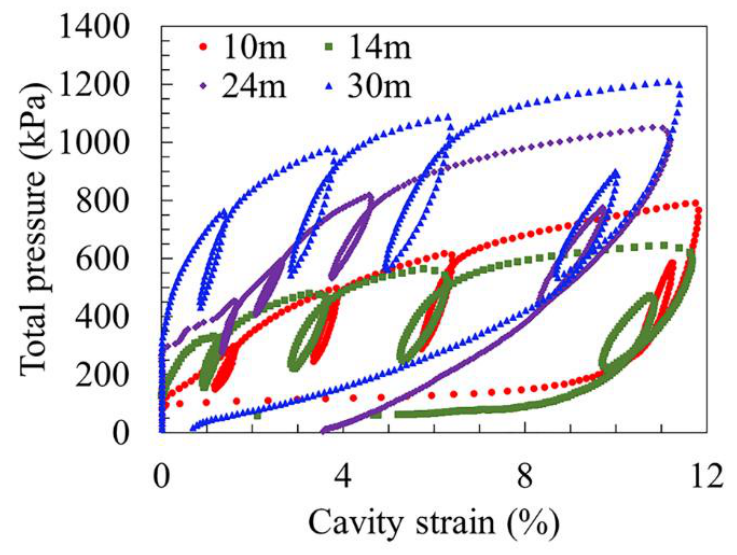
Figure 4. An illustrative diagram showing the relationship between the total pressure and the cavity strain.